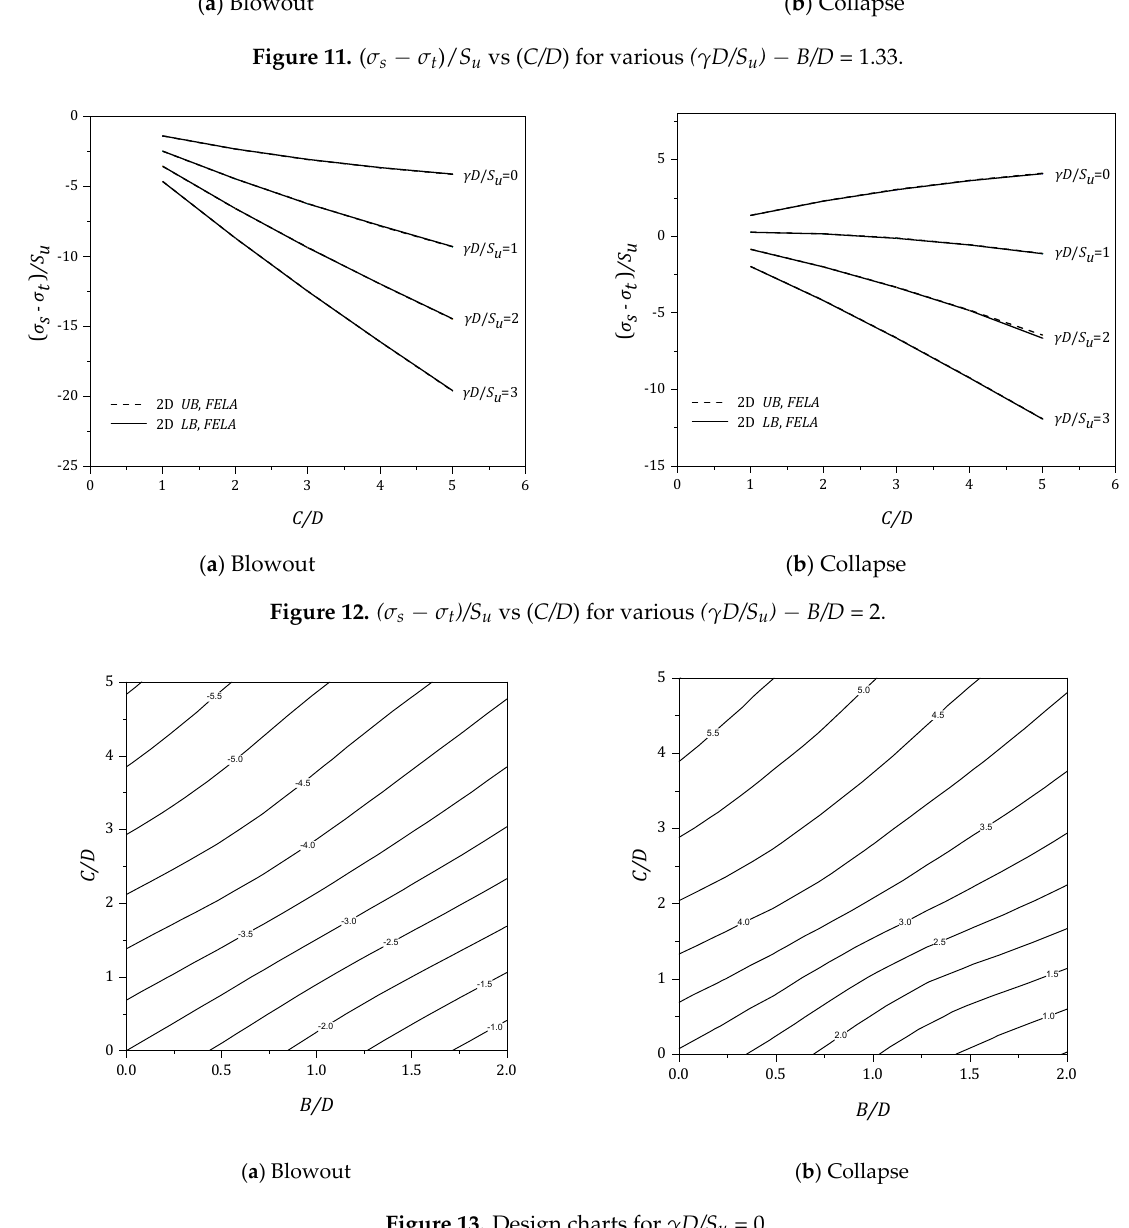
Figure 13. Design charts for γ D/S u = 0